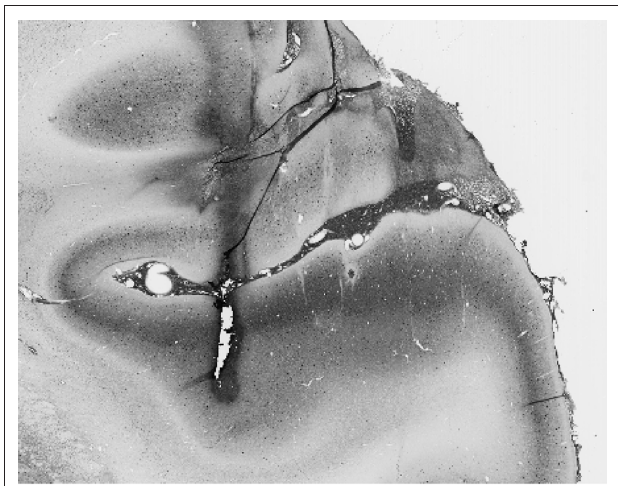
FiGure 2 | A parvalbumin-stained coronal section. The track reveals the effects of an electrode dipped in biotinylated dextran amine inserted about an hour before sacrifice, and lies on the border between primary auditory cortex and the middle medial belt. The densely stained band lateral to the track is characteristic of A1